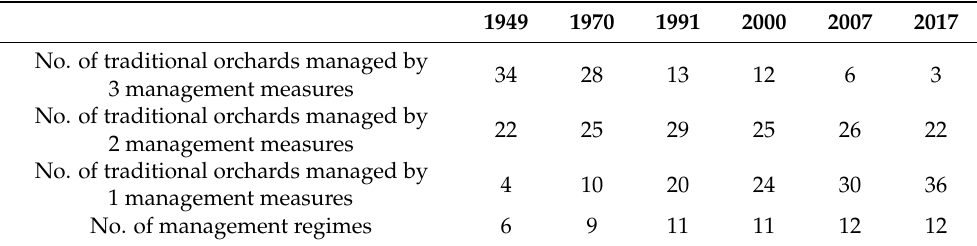
Table 2. Changes in orchard management over the period